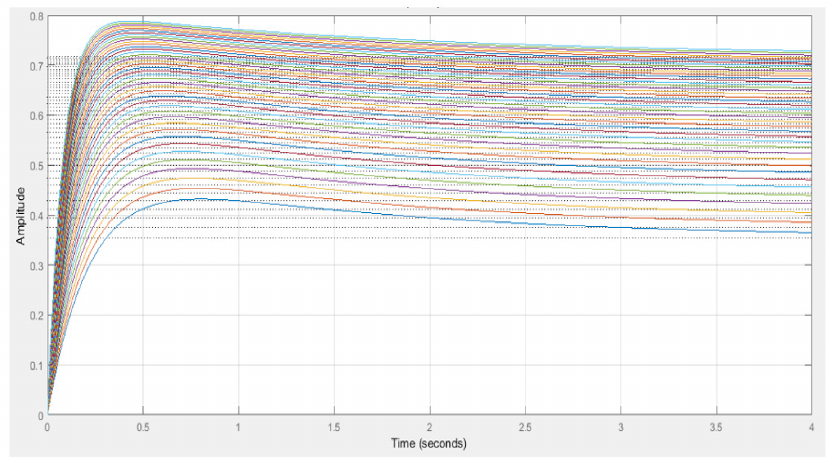
Figure 12. Step response of compensated 41 bus Nigerian 330 kV